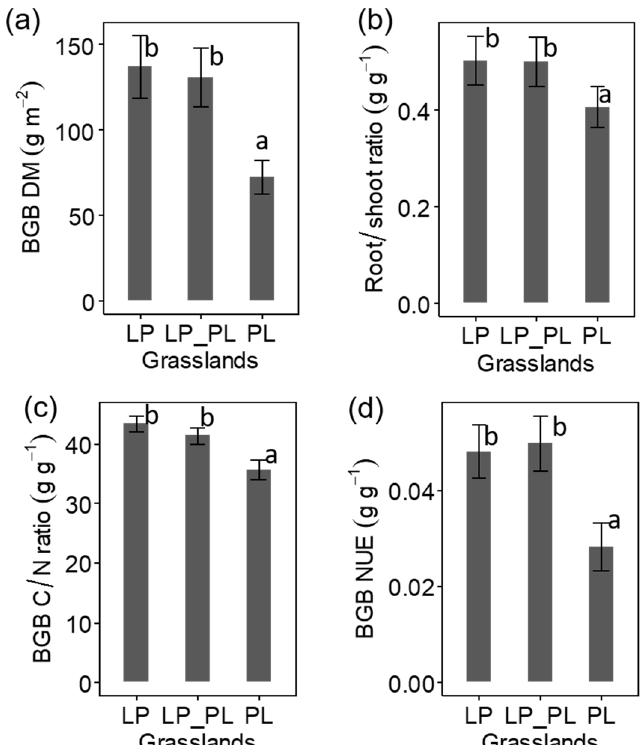
Figure A2. Sward effect on ( a ) the belowground (BGB) DM yield, ( b ) root/shoot ratio, ( c ) BGB C/N ratio and ( d ) BGB nitrogen use efficiency (NUE). Differing letters indicate significant differences ( p < 0.05); error bars indicate standard errors of the mean.